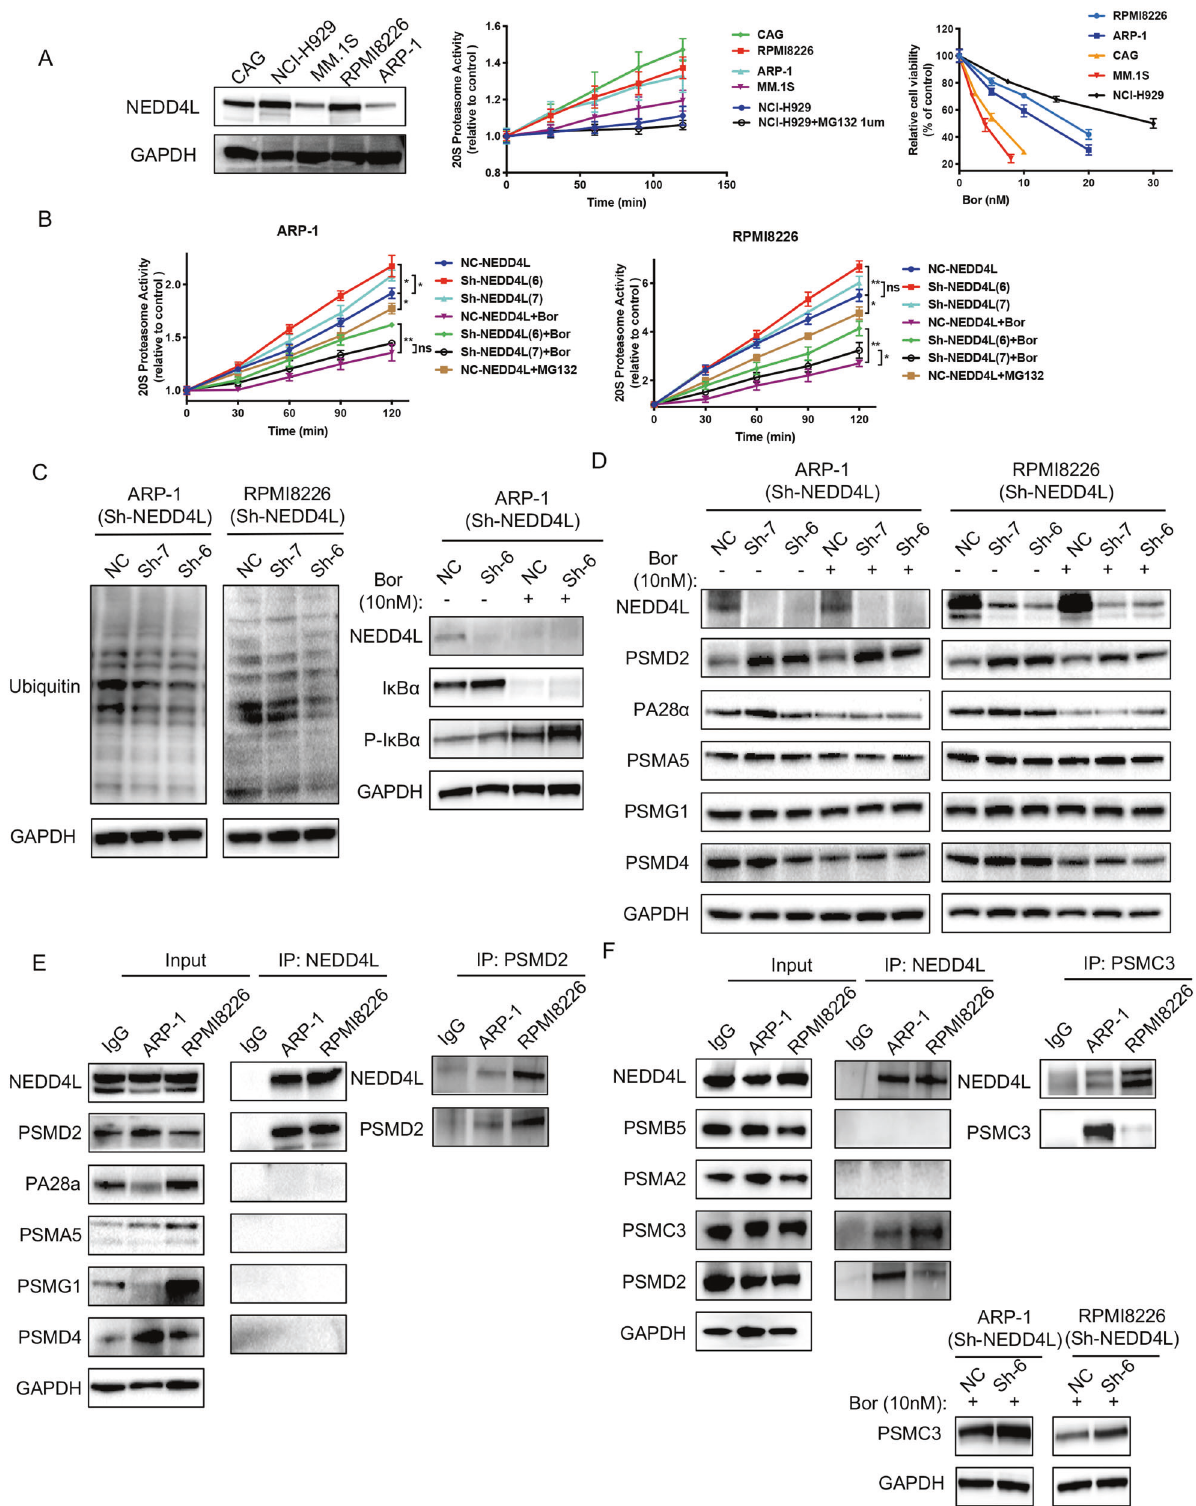
hepatocellular carcinoma (HCC) cells (Supplementary Fig. 2H). Taken together, the above data suggested that NEDD4L regulated proteasome activity and proteasome subunit expression and interacted with the 19S proteasome in MM.